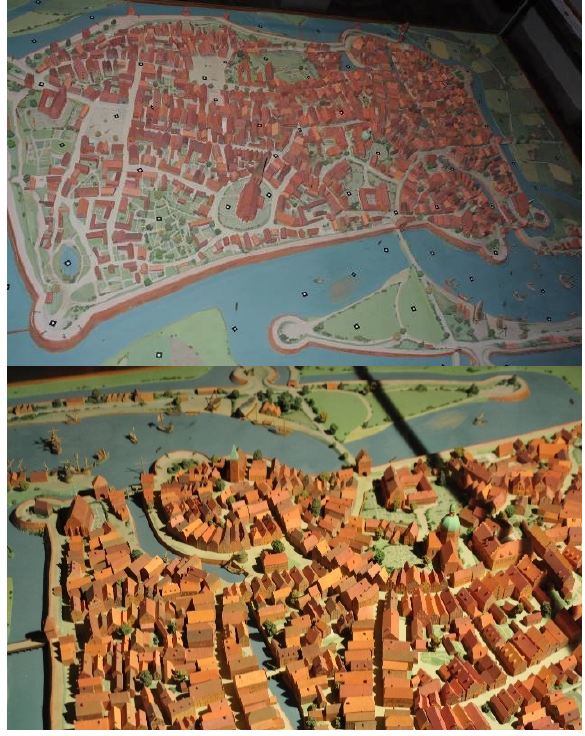
Figure 1. The historic 3D city model of Stade in the year 1620 and a part of the physical model in the town